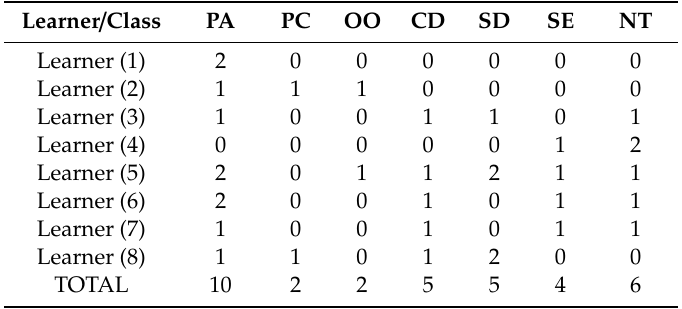
Table 14. A case study of FCS learner participation for Group 1.